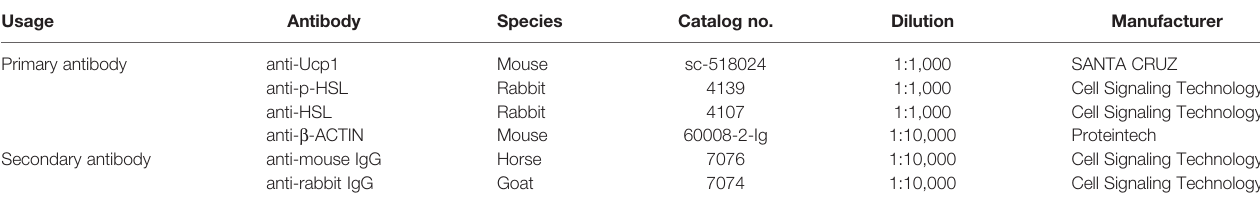
TABLE 1 | Antibodies used for immunohistochemistry and western